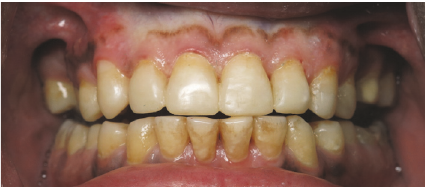
Figure7:Improvedincisal/anteriorguidancewithcompositebuild-